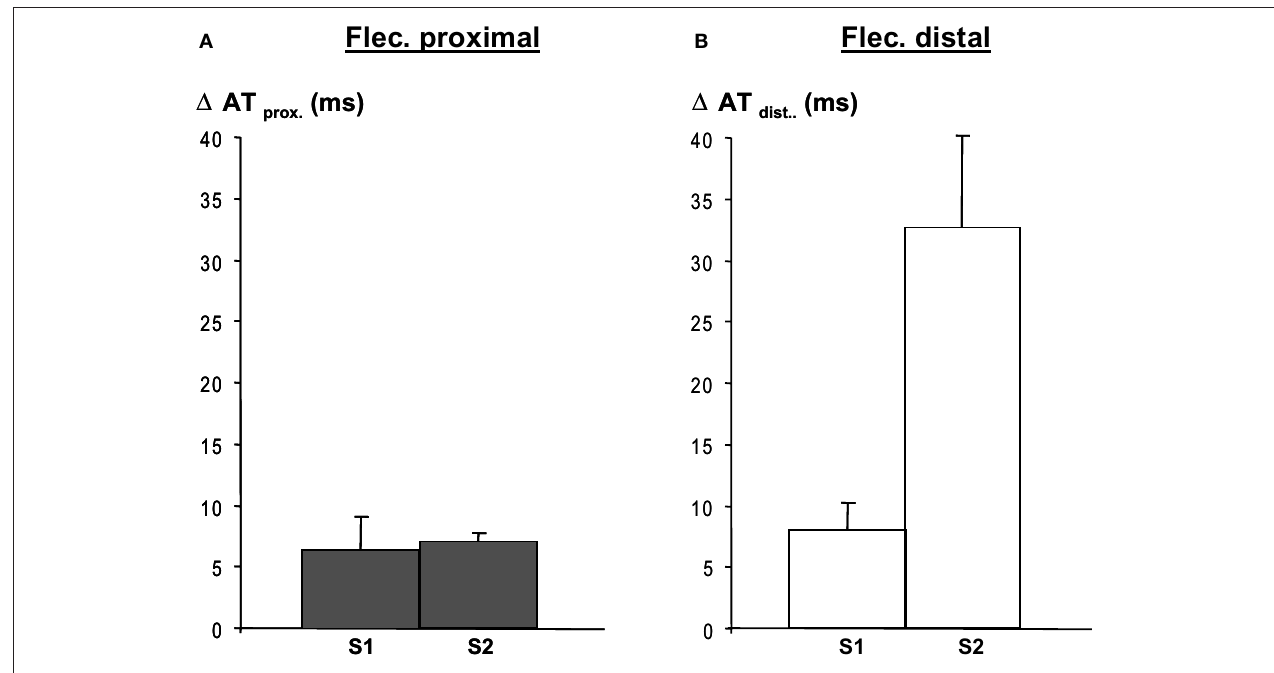
distal region than in the proximal regional, because the activation pathway is longer than in the latter. Distal activation times were calculated relative to the earliest arrival at the border between the perfusion beds. Activation delays in the domain not perfused with flecainide, no change in activation time occurred (not